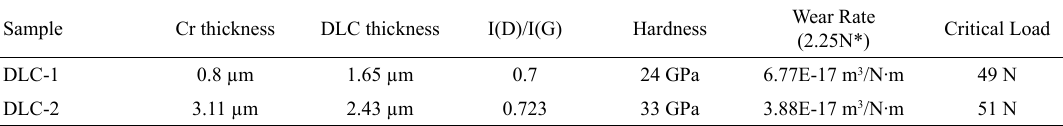
Table 2. Results summary